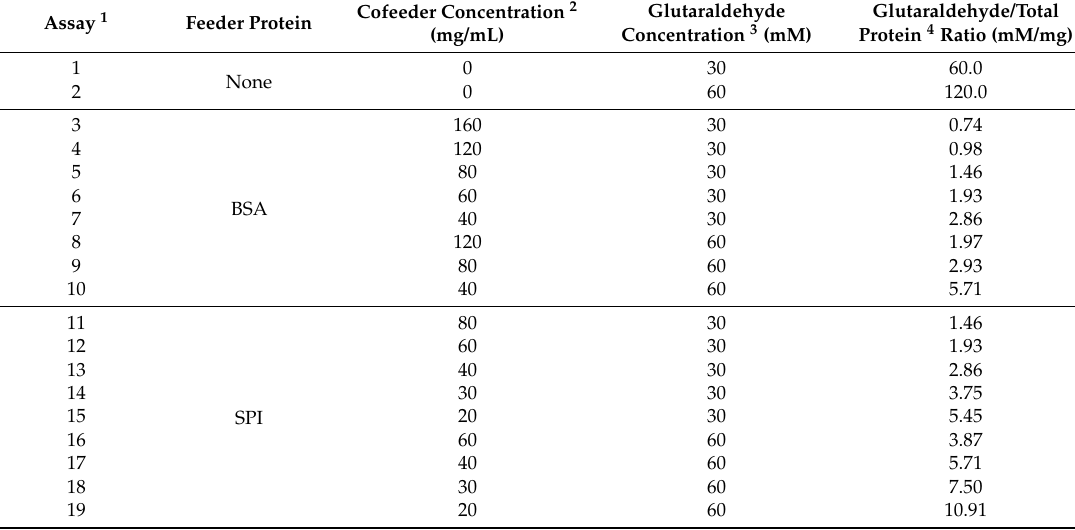
Table 3. Conditions of preparation of CLEAs of β -amylase using bovine serum albumin (BSA) and soy protein isolate (SPI) as cofeeder and glutaraldehyde as crosslinker.